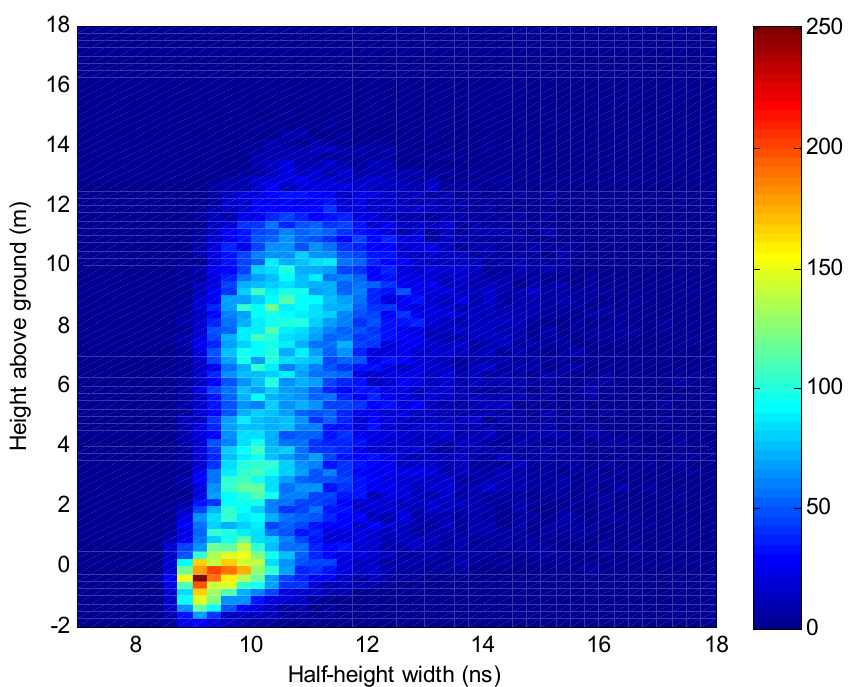
Figure 7. Bivariate frequency distribution of half-height width of Gaussian curves fitted to deconvolved waveform LiDAR vs . height above ground.